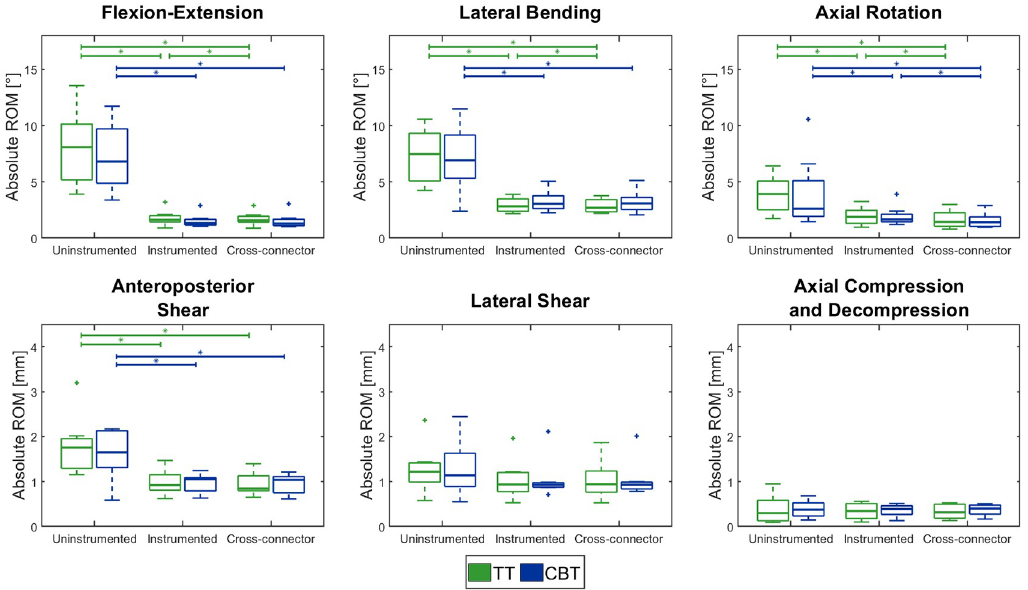
Fig 4. Range of motion. Boxplots for the range of motion (ROM) for uninstrumented, instrumented and cross-connector configuration between TT (green, left) and CBT (blue, right) shown for flexion-extension, lateral bending, axial rotation, anteroposterior shear, lateral shear and axial compression/decompression. Significant differences between the configurations are marked with asterisks (p < 0.05), TT = traditional trajectory, CBT = cortical bone trajectory. Figure generated by the authors.